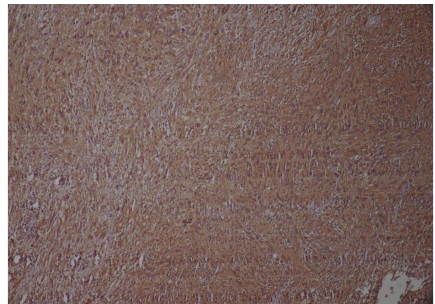
Figure 8: Schwann cells showing strong and diffuse positivity of S-